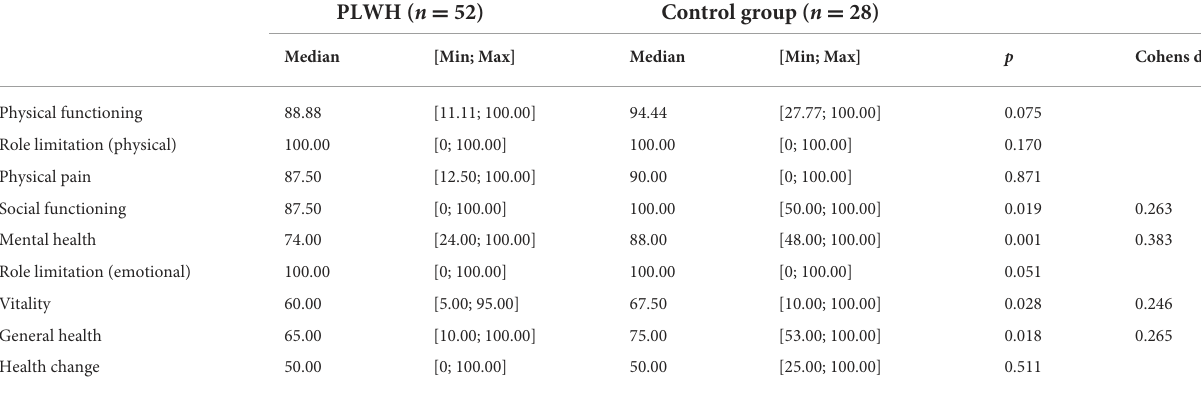
TABLE 3 Results of the SF-36 related to the dimensions in the group comparison in the Mann-Whitney U-test. PLWH ( n =